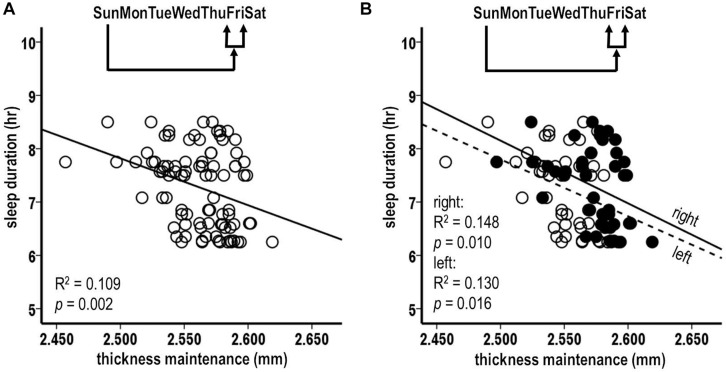
Relationships between preceding Sunday thickness maintenances and sleep durations for subsequent week Friday nights (A). Laterality analyses of fluctuations in preceding Sunday thickness maintenances for separate right (filled circles, solid regression line) and left (unfilled circles, dashed regression lines) hemispheres vs. sleep durations for subsequent week Friday nights (B). Preceding thickness maintenances of the hemispheres taken together (A) or separately (B) were significantly inversely related to sleep durations on subsequent Friday nights.